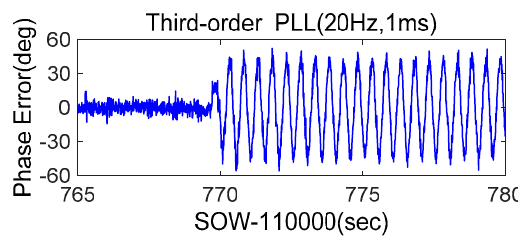
Figure 12. Phase error of stand-alone third-order PLL.